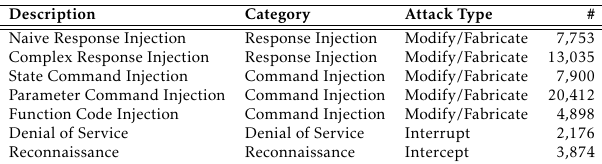
Table 2. Description, category and type of the